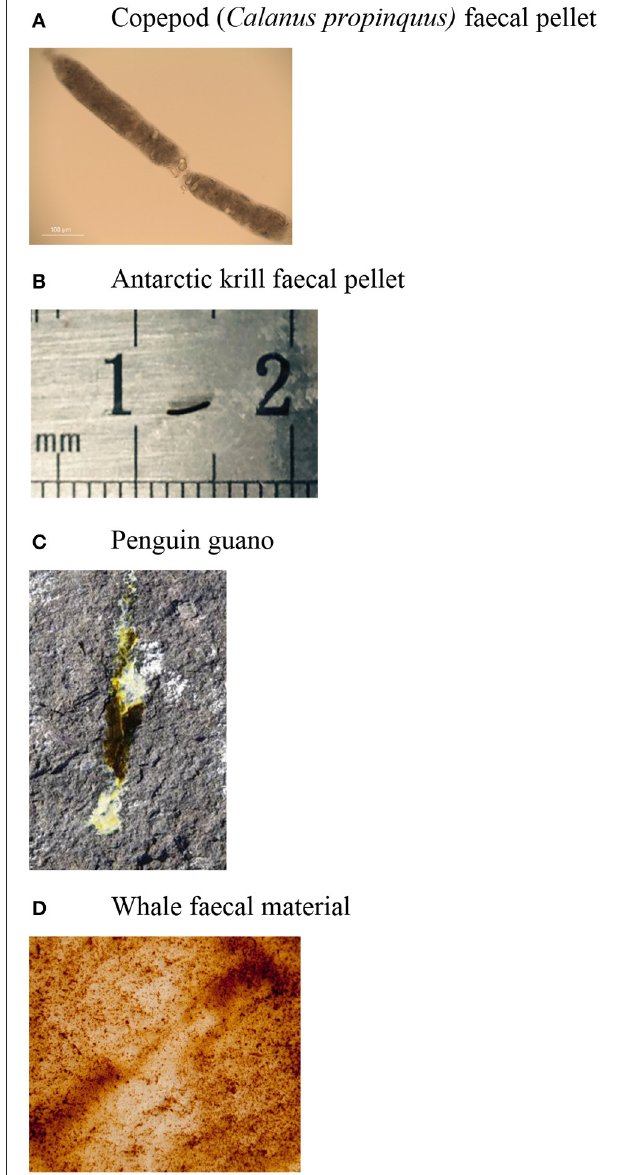
FIGURE 2 | Images demonstrating the consistency of different types of fecal material: (A) copepod ( Calanus propinquus ) fecal pellet (credit: Jake Wallis), (B) Antarctic krill fecal pellet, (C) penguin guano (credit: Louise Emmerson), and (D) whale fecal material. No copyright permissions were